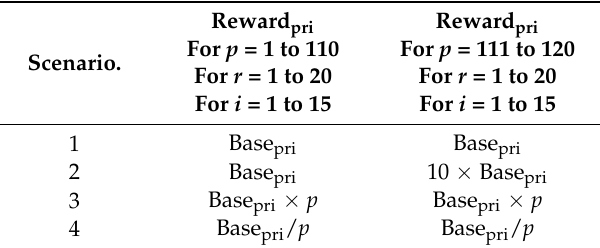
Table 2. Objective function reward per unit of slack as a function of base reward for tested scenarios.